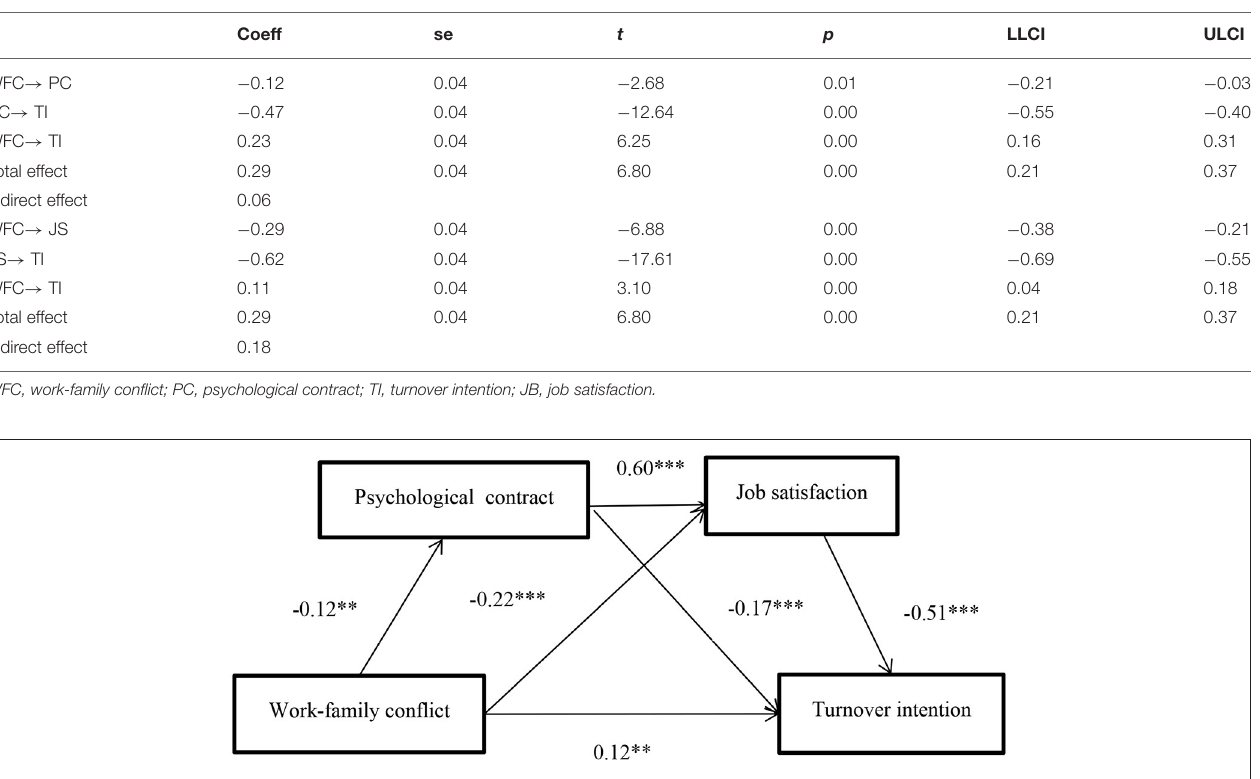
is not only a heavy workload but also very trivial (52).